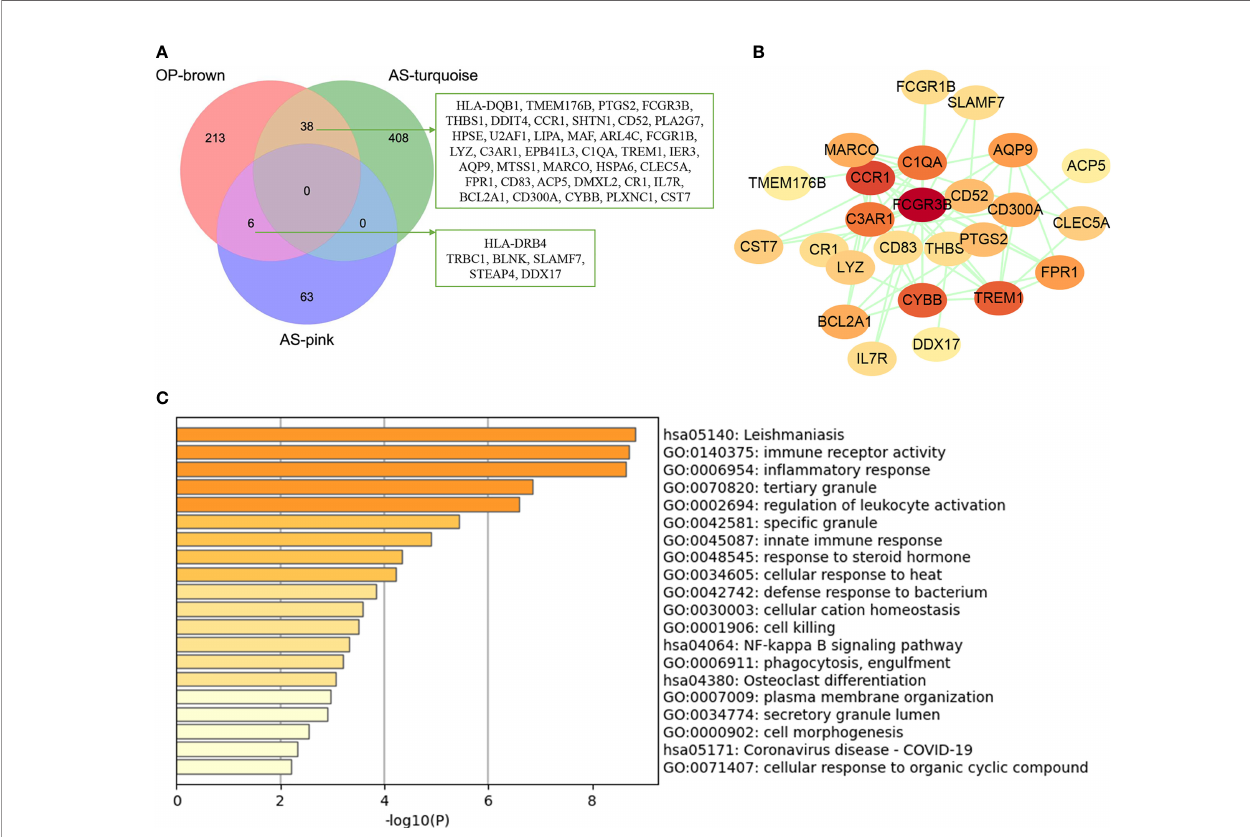
FIGURE 3 | Analysis of shared genes through WGCNA. (A) The shared genes between the MEpink and MEturquoise modules of atherosclerosis and MEbrown module of osteoporosis by overlapping them. (B) The PPI network of the shared genes. (C) GO and KEGG enrichment analysis of the shared genes. OP, osteoporosis; AS,